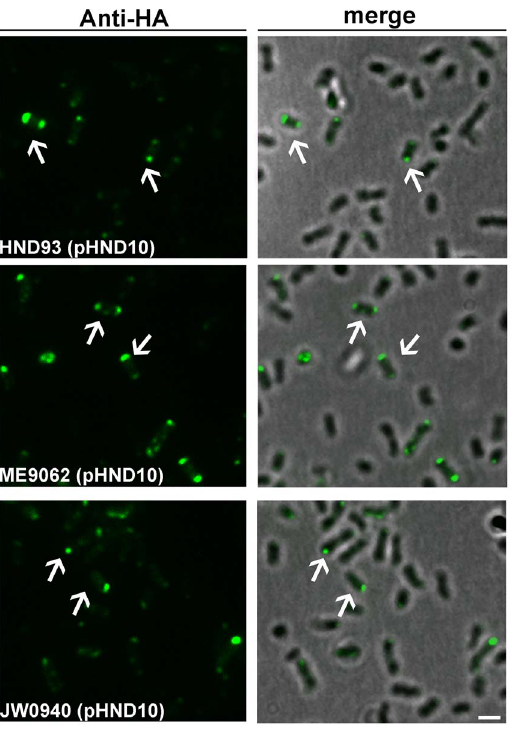
Figure 7. OmpA is not required in the process of polar localization of PhoN2-HA. Fluorescence microscopy of the S. flexneri mutant strain HND93 ( D phoN2 D ompA ), of the E. coli strain ME9062 ( ompA + ) and of its D ompA derivative strain JW0940 (Table S1) complemented with plasmid pHND10. Fluorescence microscopy and overlay of fluorescence with phase contrast images are shown. Bacteria were grown in the presence of 0.016% of L-arabinose to induce phoN2 ::HA expression and labeled with anti-HA monoclonal antibody. Panel A, HND93 (pHND10); Panel B, ME9062 (pHND10); Panel C, JW0940 (pHND10). Arrows, polar foci of PhoN2-HA. Experiments were repeated at least three times and typical results are shown. Bar =2 m m.